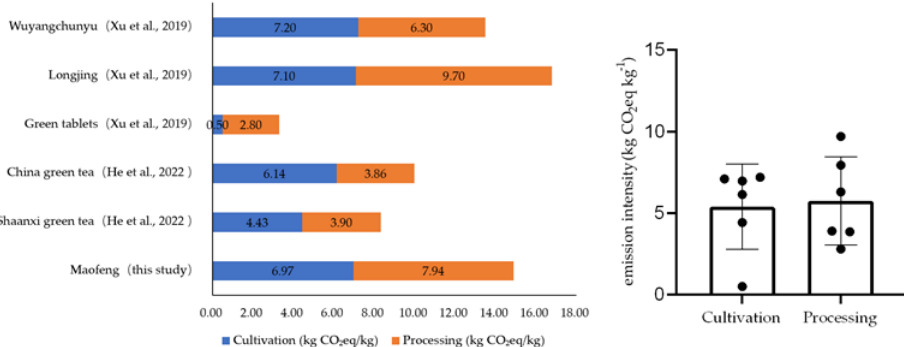
Figure 6. Comparison of carbon emissions from cultivation and processing stage in different studies. Note: In addition to the green tablets in the study by Xu et al. [22], the rest were famous green tea. The green tea studied by He et al. [9] was ordinary green tea. This article examined famous green tea; the right figure values are means ± sd .